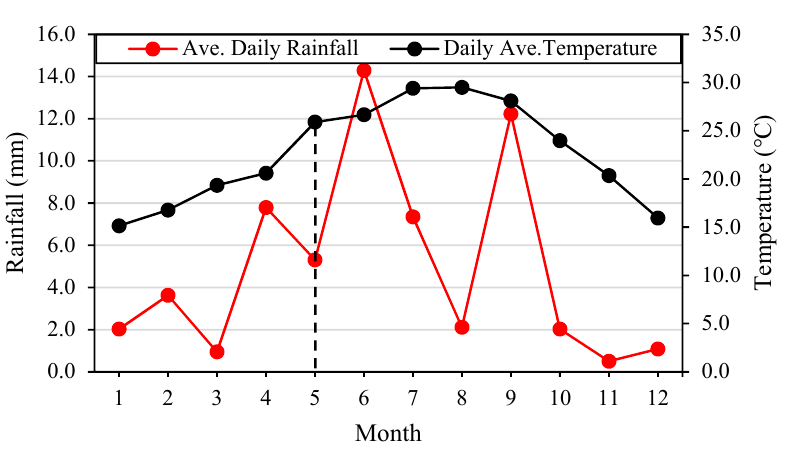
Figure 11. The monthly variation of weather conditions in DP peninsula in 2010.